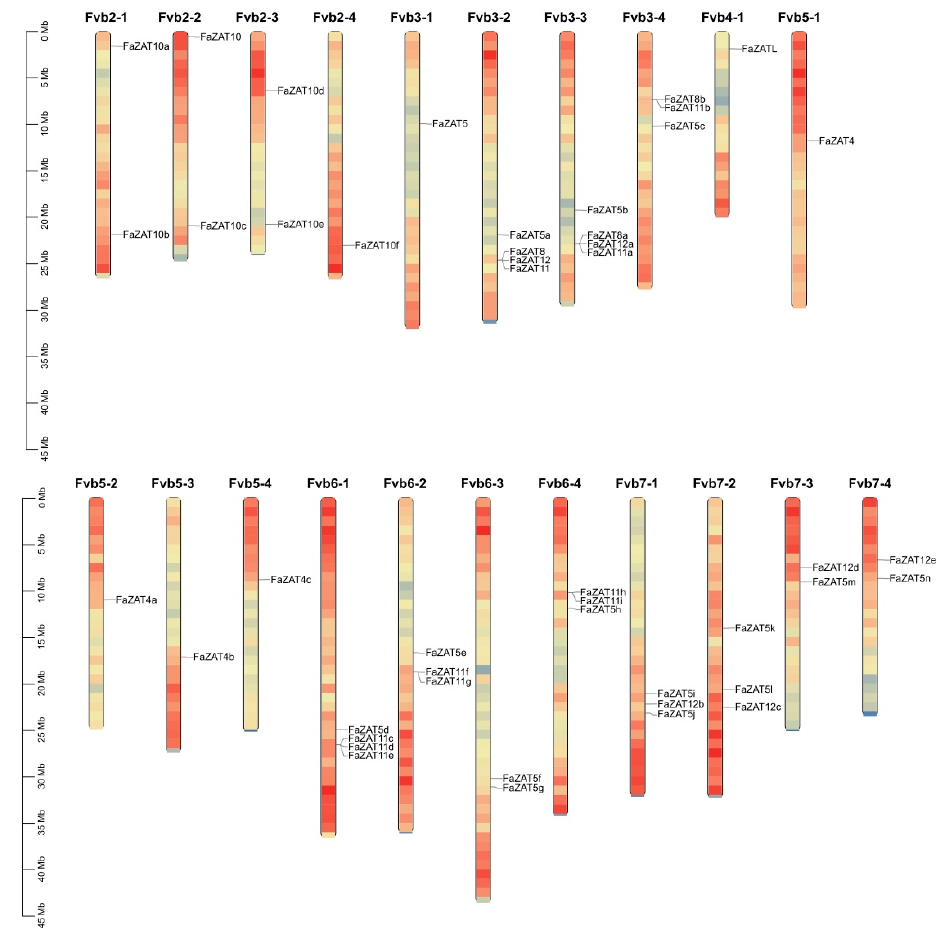
Figure 1. Chromosomal localization of cultivated strawberry C2H2-ZFP C1-2i